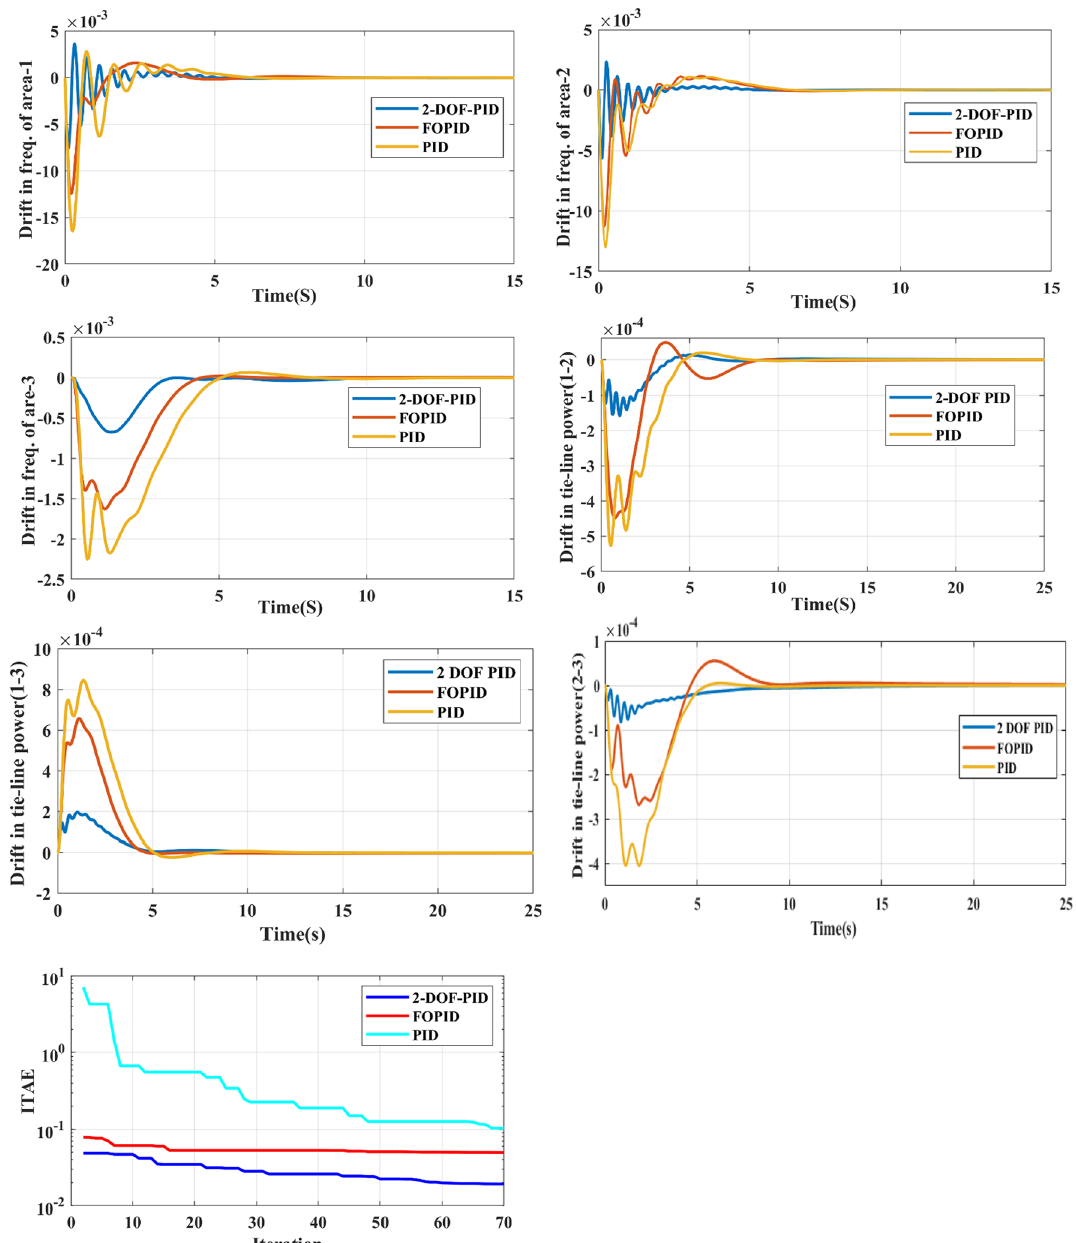
Fig. 4 Transient responses of frequency and tie-line power of all areas and convergence curves of the controllers for 2% SLD in area-1 and area-2 for 2-DOF PID, FOPIDF, and PID